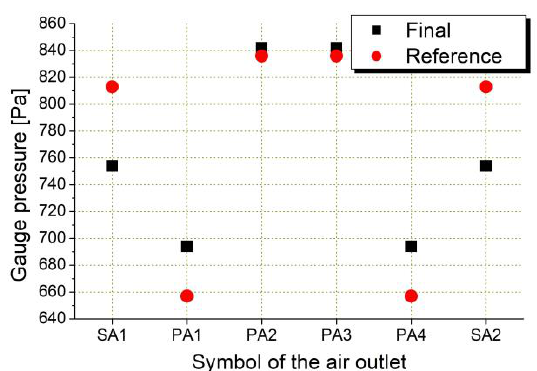
Fig. 11. Comparison of the total outlet pressures for the reference design and the prototype